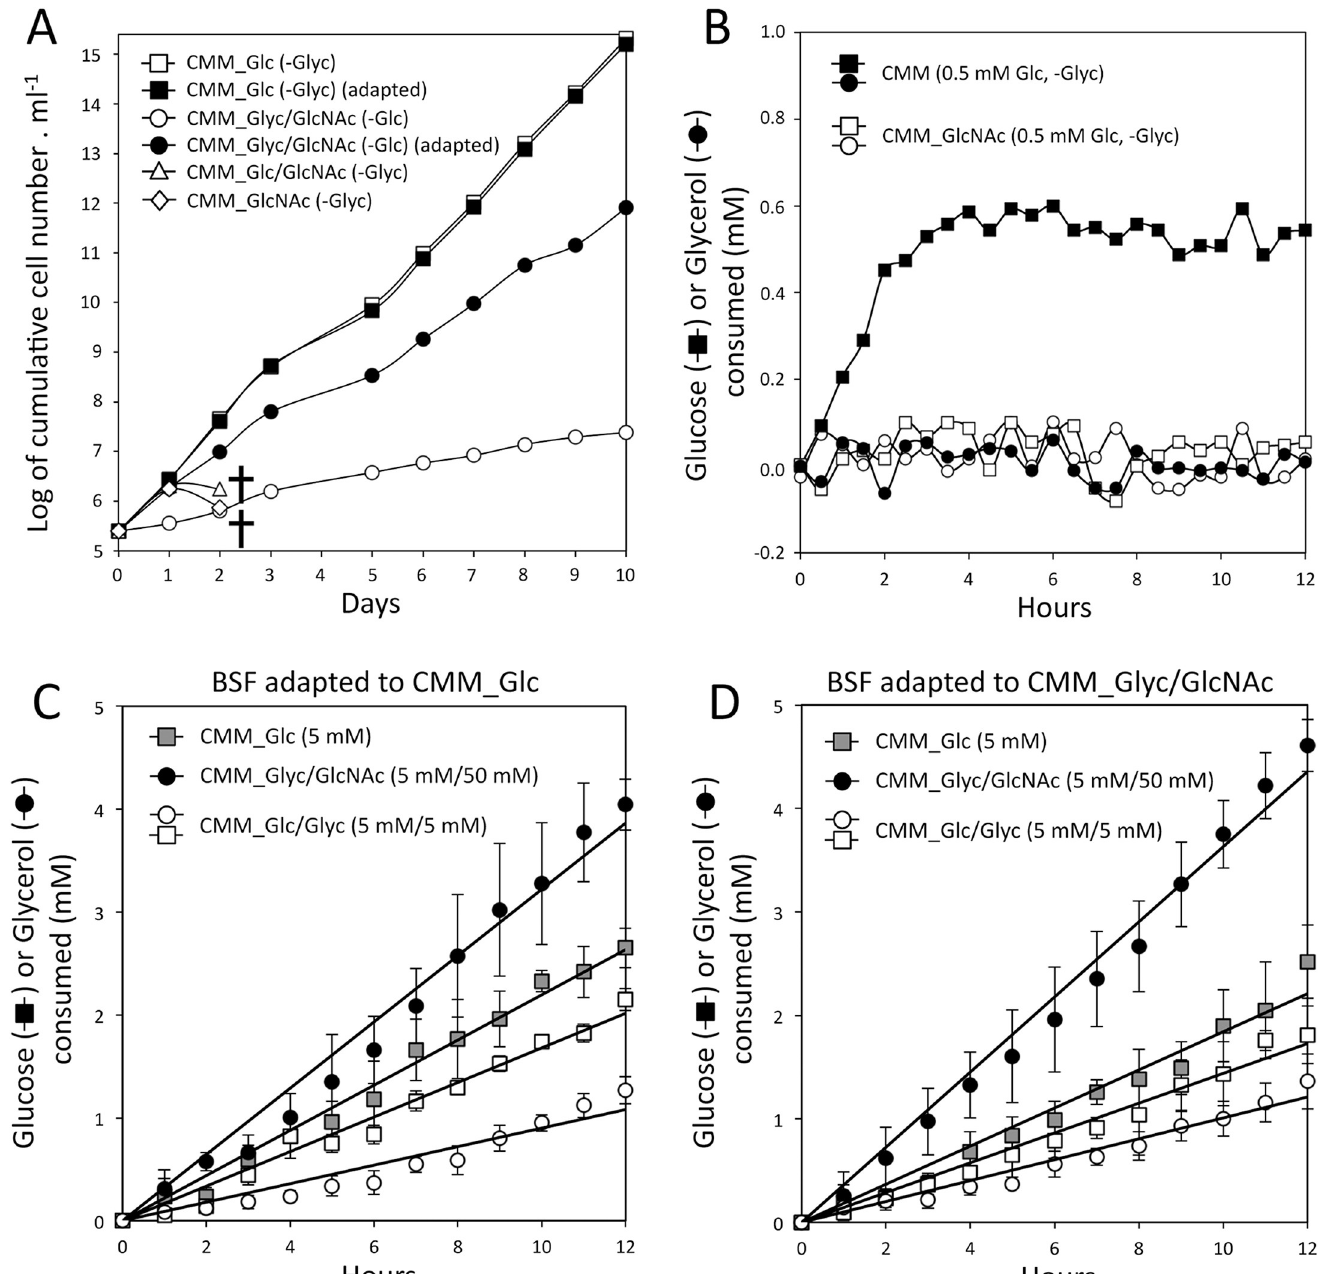
Fig 2. Glycerol supports BSF growth in the absence of glucose. Panel A shows growth curves of the 427 90–13 BSF parental strain in Creek’s minimal medium (CMM) containing 10 mM glucose (CMM_Glc), 10 mM Glucose and 50 mM GlcNAc (CMM_Glc/GlcNAc), 10 mM glycerol and 50 mM GlcNAc (CMM_Glyc/ GlcNAc), or only 50 mM GlcNAc without glucose and glycerol (CMM_GlcNAc). Filled squares and circles mean that the cells have been adapted during 3 months in CMM_Glc or CMM_Glyc/GlcNAc, respectively, before starting the growth monitoring. The crosses mean that all the cells were dead. Panel B shows glucose and glycerol consumption over time by the 427 90–13 BSF strain incubated in CMM and CMM_GlcNAc containing 0.5 mM glucose and no glycerol. Panels C and D show the same experiment as in panel B with cells incubated in CMM_Glc, CMM_Glyc/GlcNAc or CMM_Glc/Glyc (CMM containing equimolar amounts of glucose and glycerol) containing 5 mM glucose and/or glycerol (error bars indicate means ± SD of 3 biological replicates). Before the experiment, BSF have been grown for at least one month in CMM_Glc (panel C) or CMM_Glyc/GlcNAc (panel D).